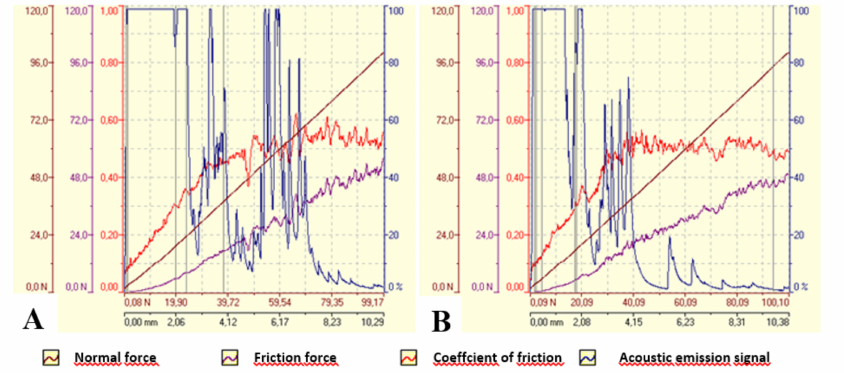
Figure 5. Scratch tests results for Ni-P/Si 3 N 4 coatings: ( A ) Ni-P/Si 3 N 4 (2 g/dm 3 ); ( B ) Ni-P/Si 3 N 4 (5 g/dm 3 ).